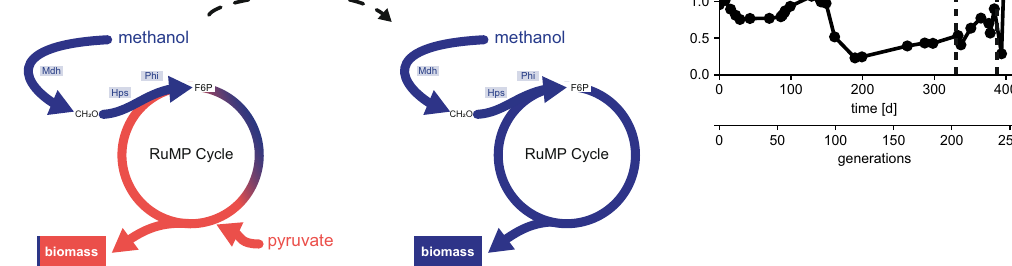
Fig. 2 | Long-term evolution of the strain Δ frmA Δ tpiA . a Methanol (blue) and pyruvate (red) in the feed medium were applied in concentrations thatensured an excess of methanol(500mM) in the bioreactor while pyruvate waskept limiting (< 0.01mM). b Targeted metabolic adaptation of the methanol-dependent strain towards the formation of almost the entire biomass from pyruvate to growth on methanol alone. c Experimental boundary conditions, i.e. the concentrations of